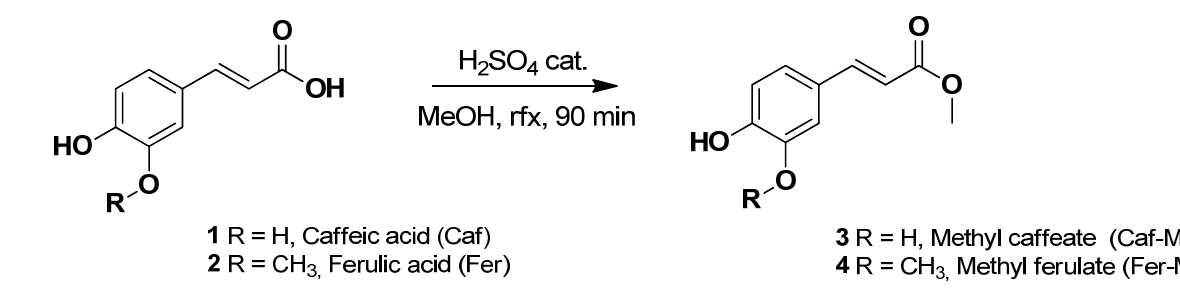
Figure 1. Synthesis of Caf-Me ( 3 ) and Fer-Me ( 4 ) via Fischer esterification.